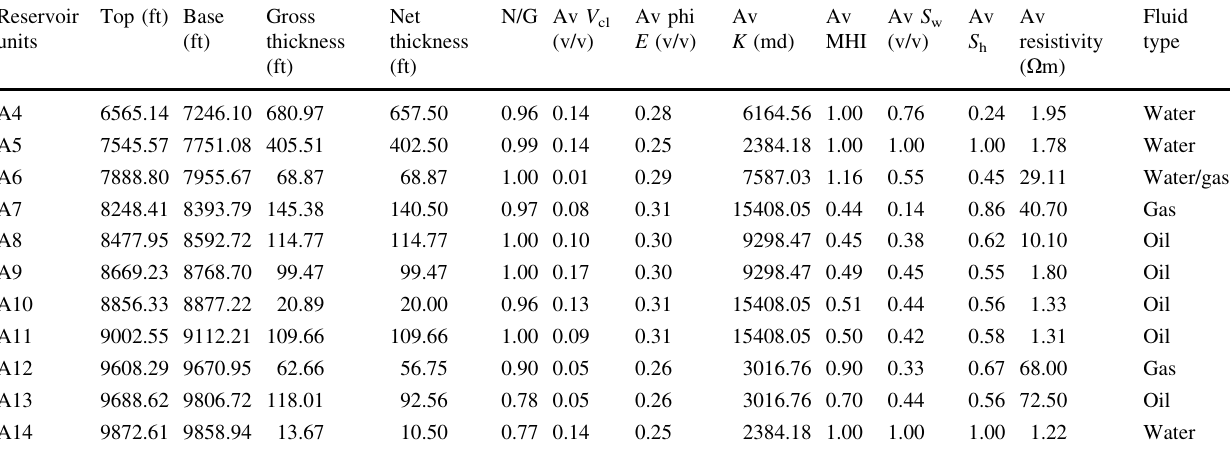
Table 3 Average petrophysical parameters for the reservoirs in JAP-2 well Reservoir units